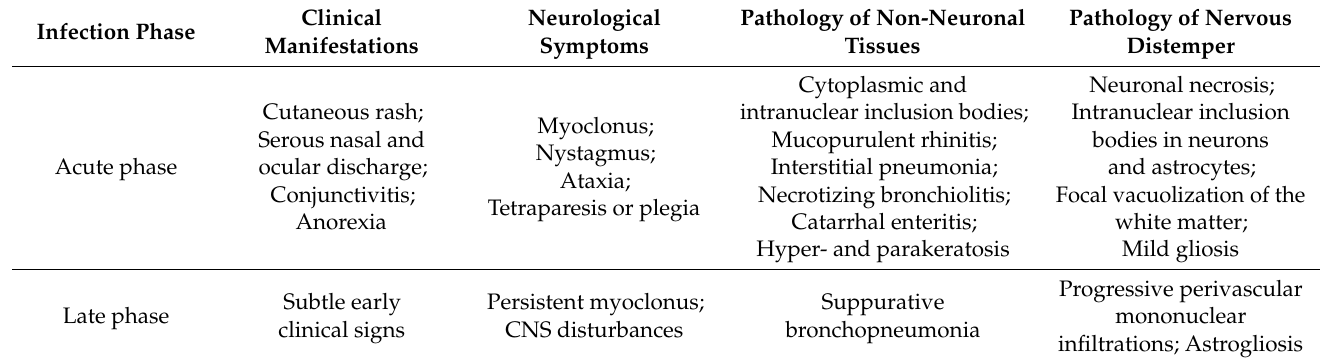
Table 1. Comparison of symptoms and pathological changes in acute and late stages of CDV